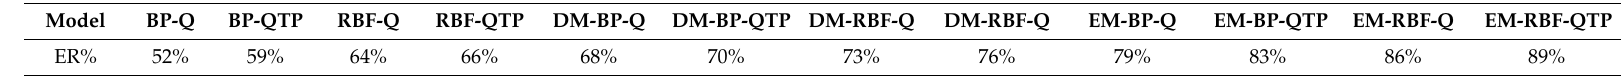
Table 14. An acceptable rate of forecasting for peak values during the flood season (May–October) for Zone Three.